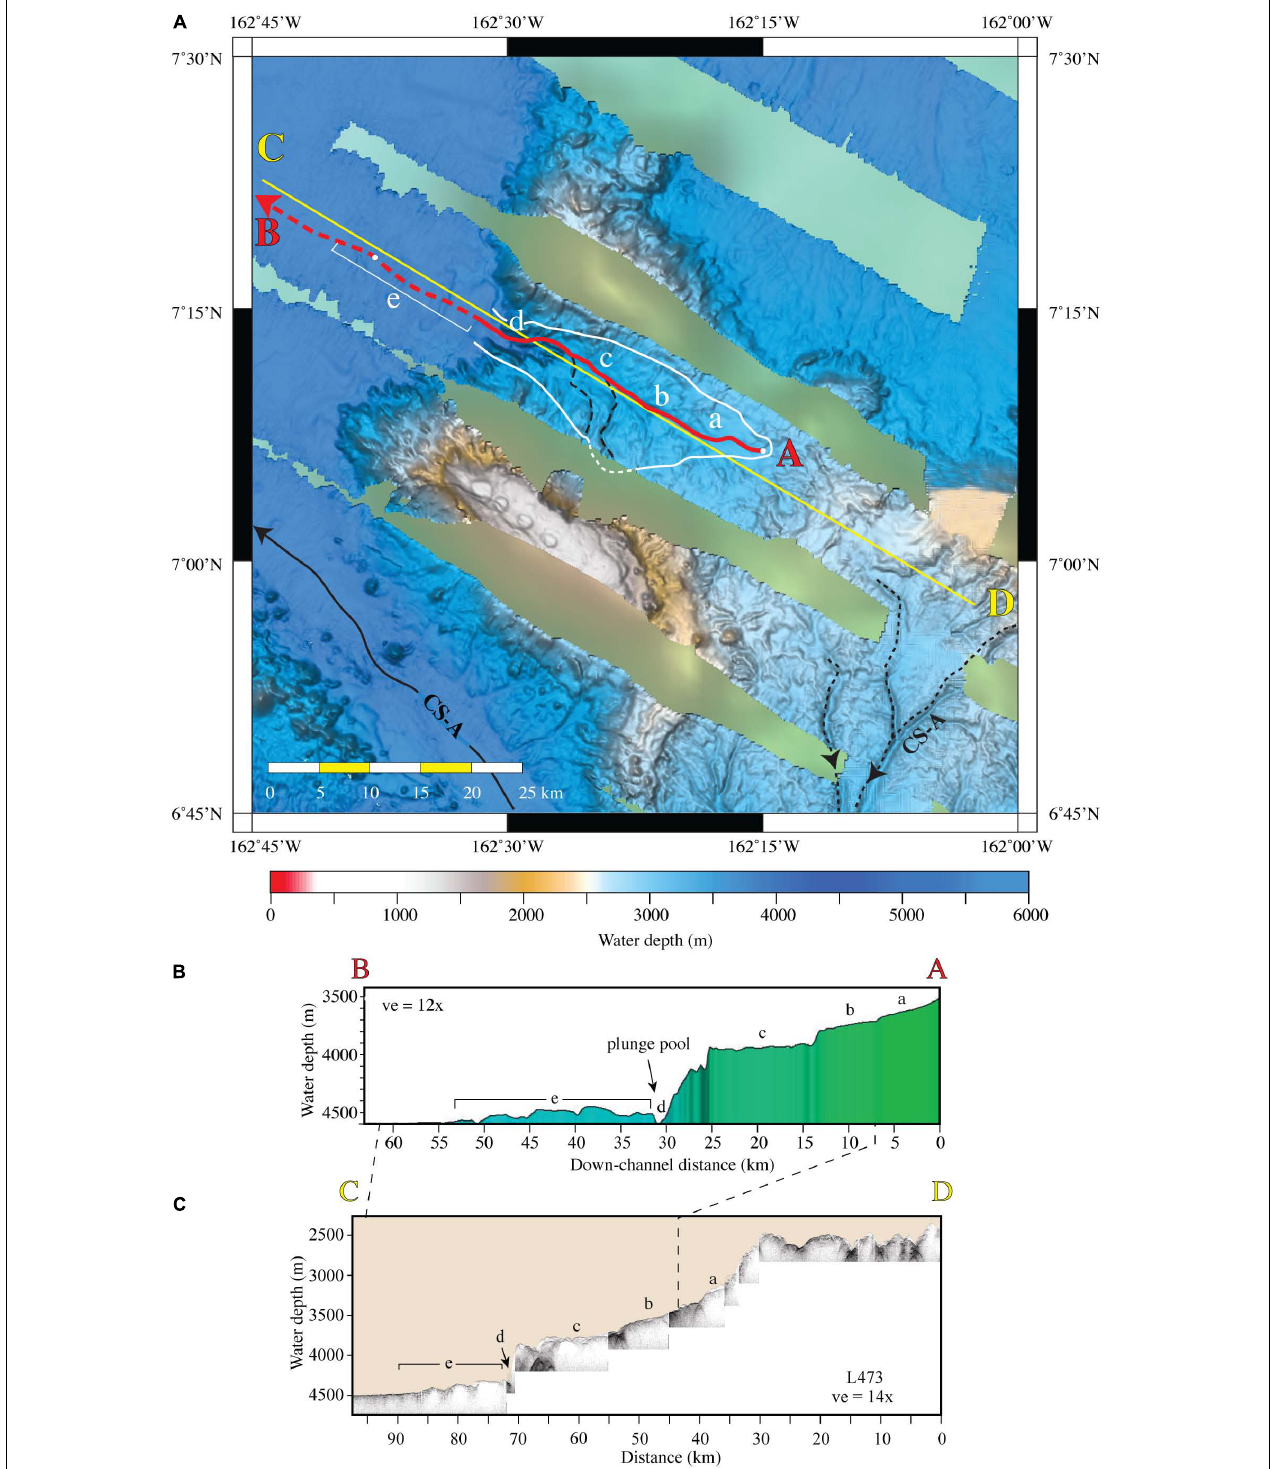
FIGURE 8 | (A) Map view of multibeam bathymetry of the upper reach of the west branch tributary of channel system CS-A. Drainage area (see text) outlined in white (dashed in areas with no MBES data). Red line shows path of the main tributary channel; dashed red line is approximate path with white circles at 50-km down channel. Black dashed lines are adjacent tributaries of CS-A main channel and solid black line is main channel reach of CS-A. White letters a-c locate steps of the NW escarpment of the northern Line Islands Ridge in this area; letter d is location of a plunge pool and letter e is a sediment bank immediately down channel from the plunge pool (see text for discussion). (B) Down-channel profile of head of the west branch tributary. (C) Subbottom seismic line 473 that crosses the NLIR escarpment and descends to abyssal depths. Location of subbottom line C–D shown on (A) .